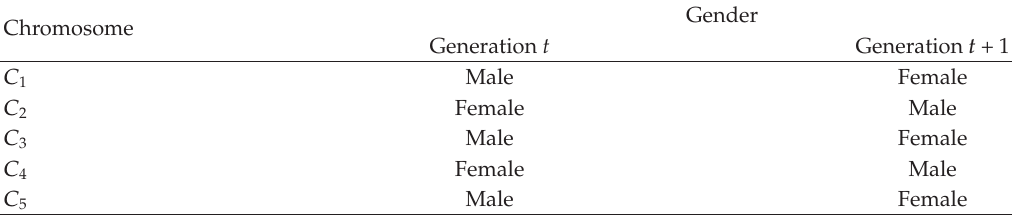
Table 3: The layout of male and female